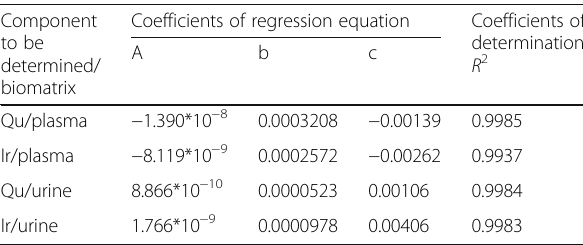
Table 1 The coefficients of the regression equation of calibration curve (Y = a ∙ X 2 + b ∙ X + c) and coefficients of